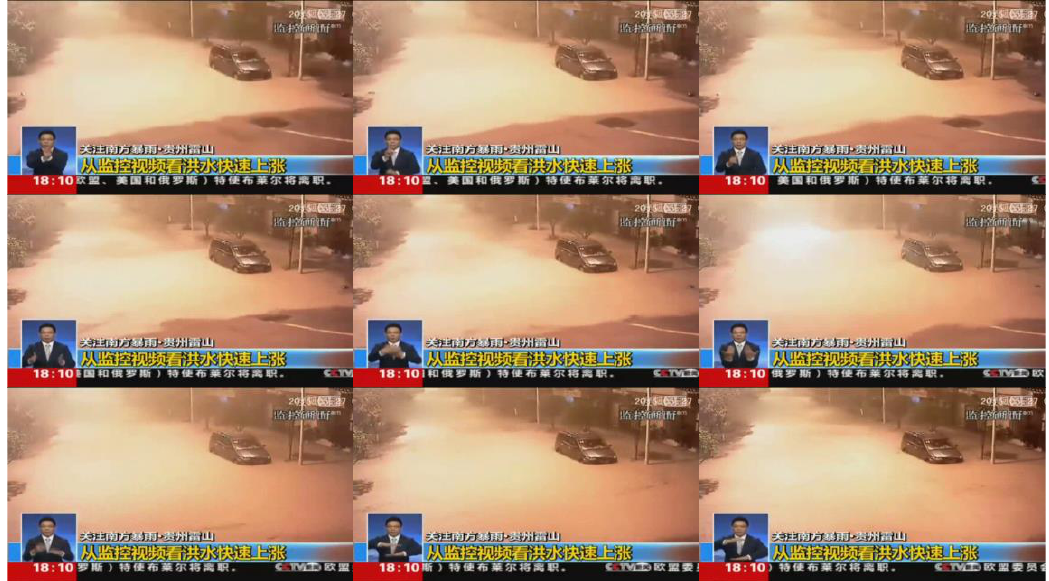
Figure 3. Sample images of video data set 2 in a city in Guizhou Province, China.